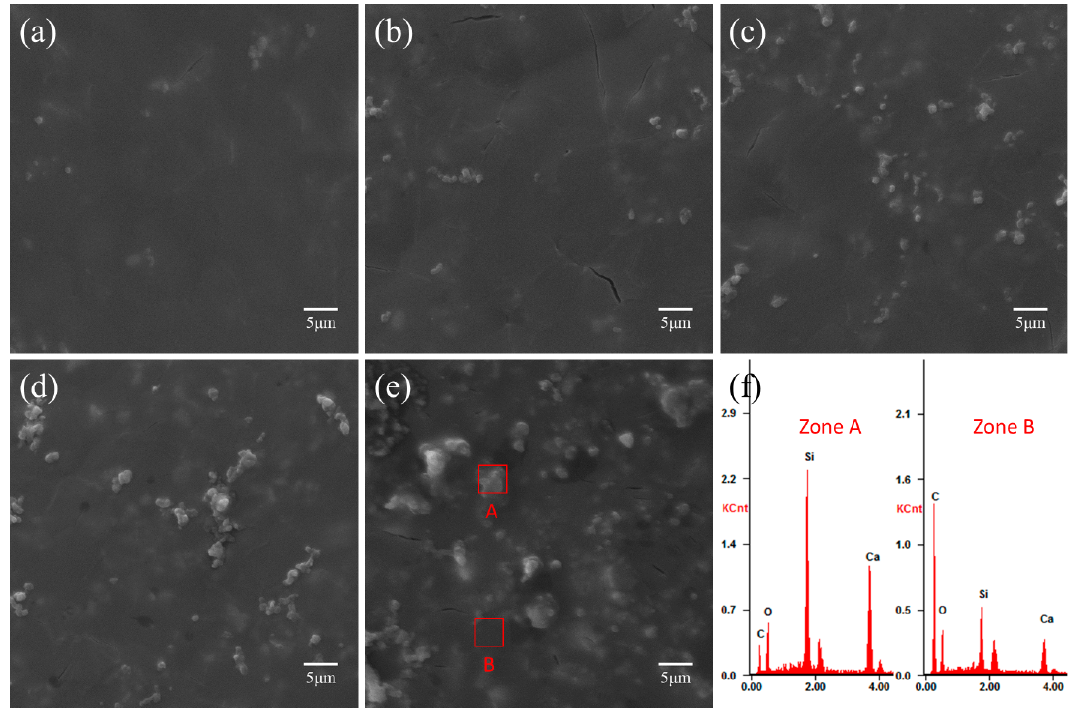
Figure 4. SEM surface morphologies of ( a ) PHBV scaffold; ( b ) PHBV/5%CS scaffold; ( c ) PHBV/10%CS scaffold; ( d ) PHBV/15%CS scaffold, and ( e ) PHBV/20%CS scaffold; and ( f ) the EDS (energy-dispersive spectroscopy) spectra of Zones A and B.